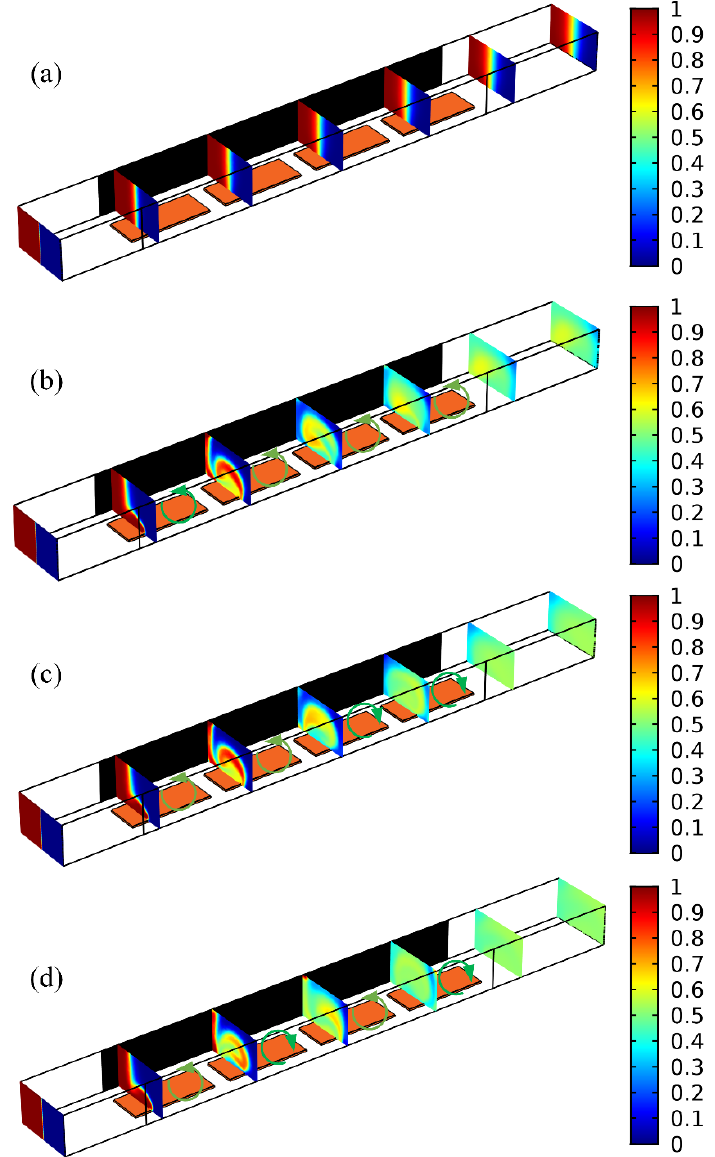
Figure 8. At an inlet flow velocity u 0 = 10 mm/s and ion conductivity 0.001 S/m, a simulation study on the influence of different combinations of ICEO vortex polarity on mixing improvement in the integrated tandem device structure with four sequential GE strips subjected to various of gate voltage sequence. ( a ) In the absence of external powering, the phase boundary between the co-flowing laminar streams is stretched only by diffusive mass transfer with γ = 23.54%. ( b , c ) For V D = 14 V, ( b ) and V G 1 = V G 2 = V G 3 = V G 4 = 2.625 V are imposed on the four sequential GE, respectively, ICEO vortex in anticlockwise direction appears on the ideally polarizable surface of all the GE strips, which twists and stretches the phase interface in synergy with mass diffusion, resulting in an nonideal device performance of γ = 88.67%, ( c ) with a given gate potential sequence of V G 1 = V G 2 = 2.625 V and V G 3 = V G 4 = 11.375 V, ICEO eddy rotates anticlockwise on the surface of two GE upstream, but polarity of the electroosmotic vortex makes a reversal on the two GE downstream, so the distance scale of electrochemical polarization equals two gate length, and the transformation in rolling direction of the phase boundary at such a longitudinal displacement leads to better mixing efficiency γ = 92.41% than ( b ); ( d ) An more frequent alternation in flow direction of lateral ICEO vortex at a shorter distance (one GE length) gives rise to even more superior device performance γ = 95.233% than ( c ). Without input of external electrical energy to the microdevice, there is no ICEO turbulence for electro-convective mixing, and the sole action of molecular diffusion produces a poor mixing